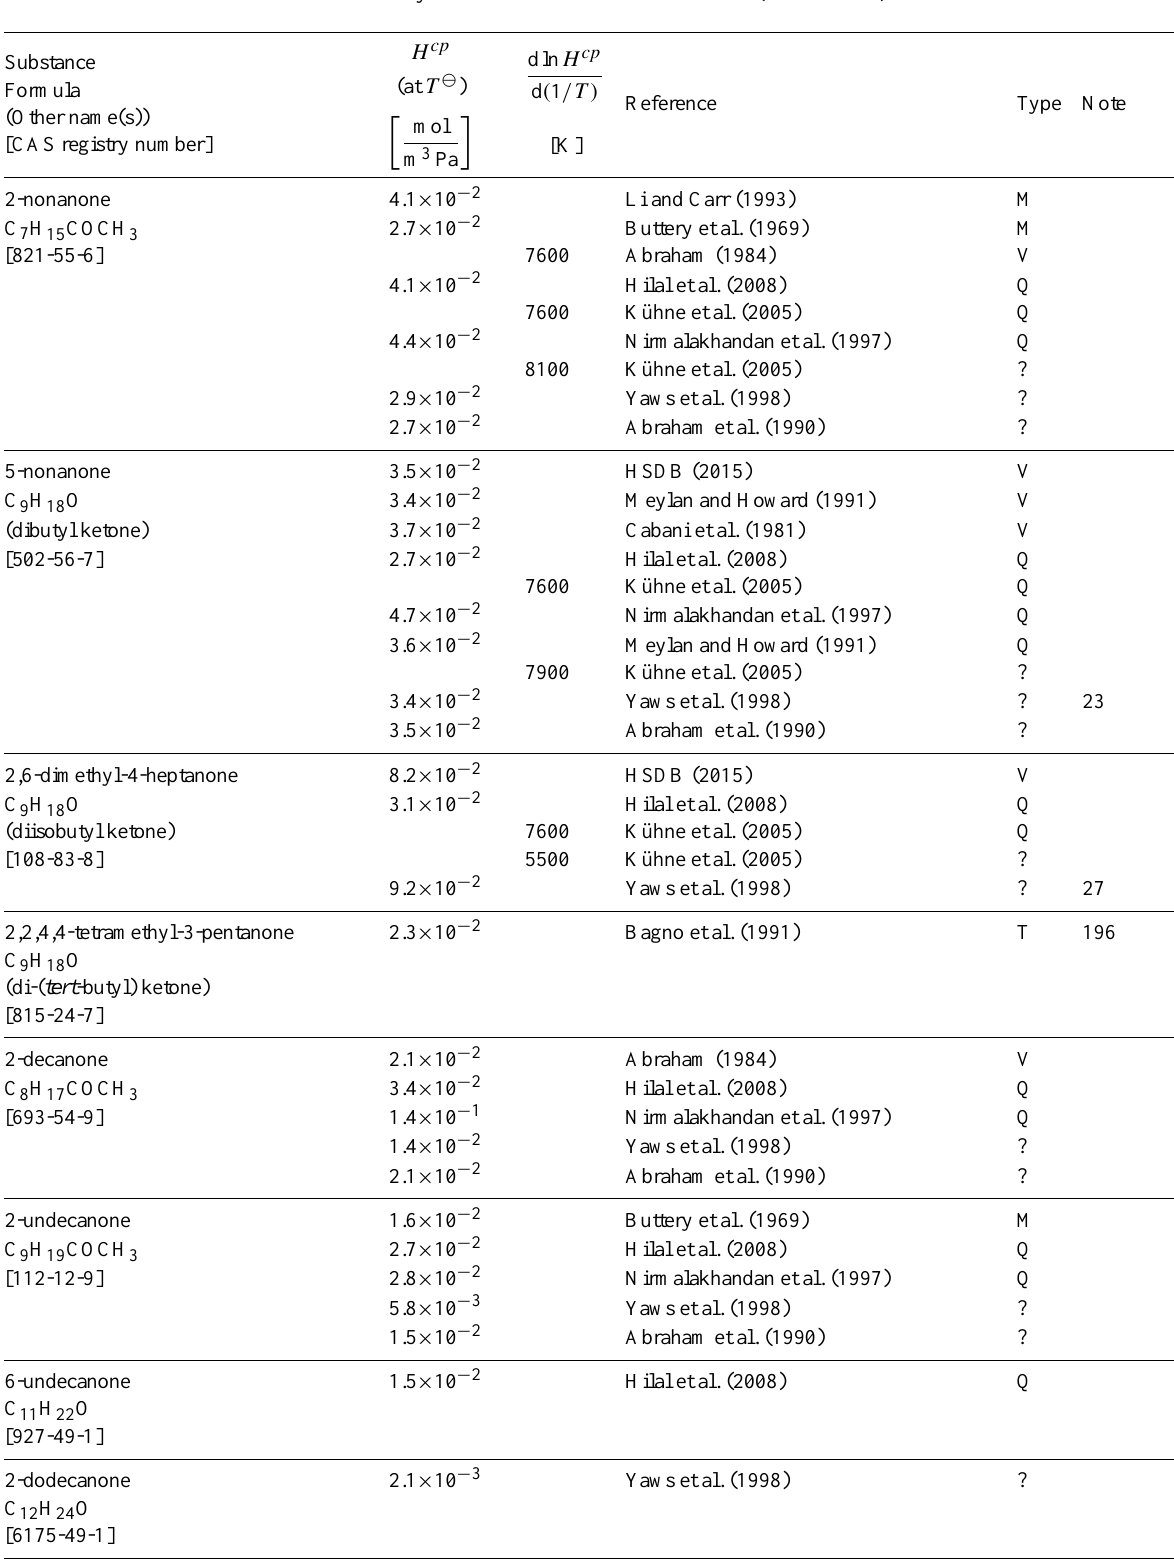
Table 6: Henry’s law constants for water as solvent